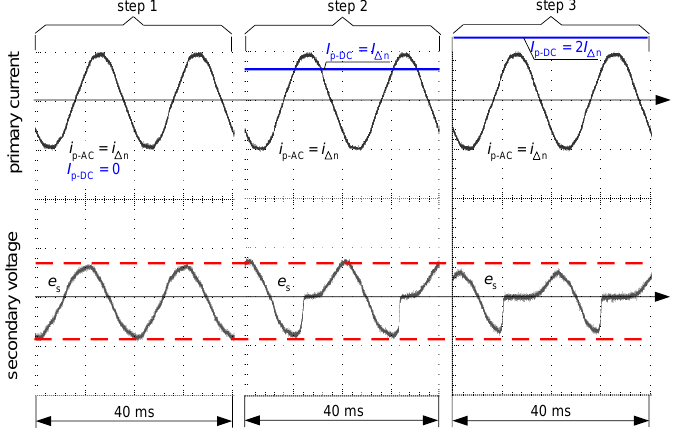
Figure 17. Oscillograms of the induced secondary voltage e s in case of the iron core of flat hysteresis loop (as in Figure 15b). Primary current i p composed of sinusoidal AC waveform ( i p-AC = i ∆ n ) and DC component ( I p-DC ) of the consecutive values: I p-DC = 0 (step 1), I p-DC = I ∆ n (step 2), I p-DC = 2 I ∆ n (step 3).